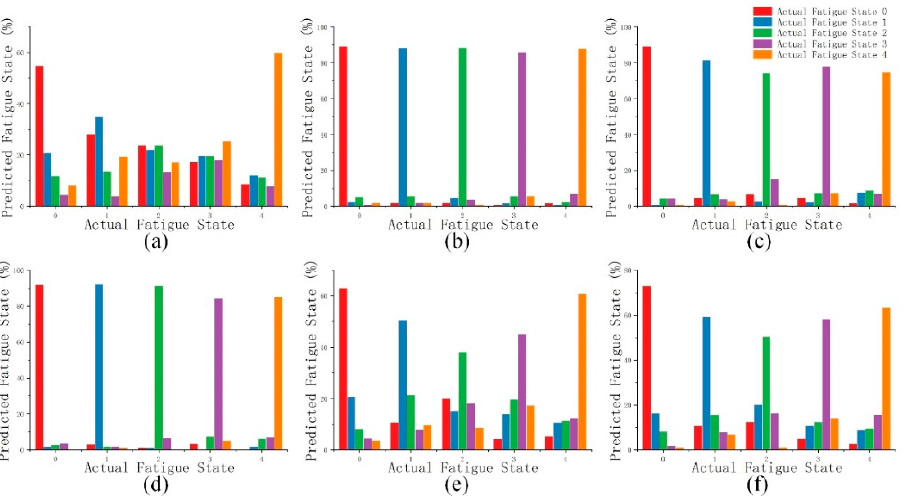
Figure 7. ( a ) Logistic regression prediction results. ( b ) Random forest prediction results. ( c ) GBDT prediction results. ( d ) SVM RBF prediction results. ( e ) SVM linear prediction results. ( f ) SVM poly prediction results.